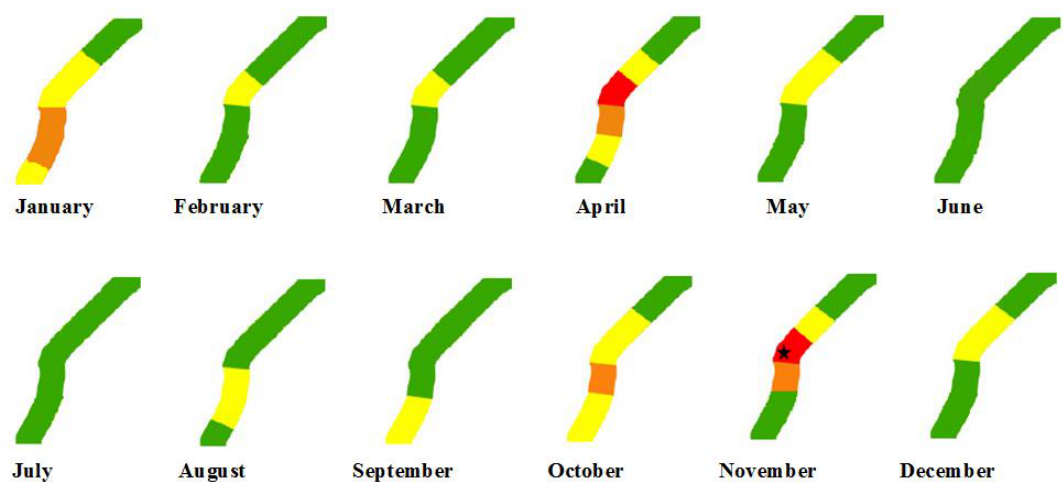
Figure 6. A comparison between the predictive results provided by the developed model and the actual line tripping events that occurred in Huanggang (30.27° N, 114.52° E) on the first day of each month in 2015, where the black star denotes the location of an actual line tripping event.